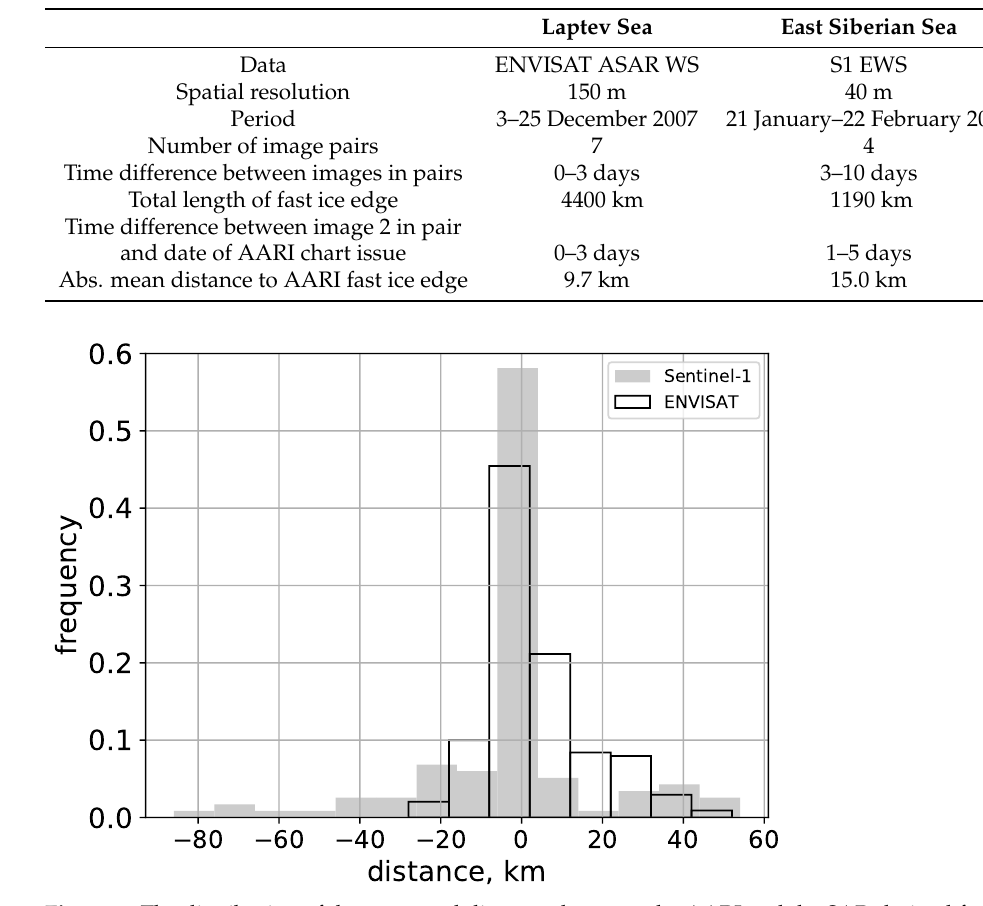
Figure 7. The distribution of the measured distances between the AARI and the SAR-derived fast ice edge from ENVISAT ASAR and Sentinel-1 data. The positive values correspond to the cases when the AARI edge is closer to the shore compared to the retrieved edge. Negative values correspond to the cases when the ice edge by the AARI experts is more advanced compared to the retrieved